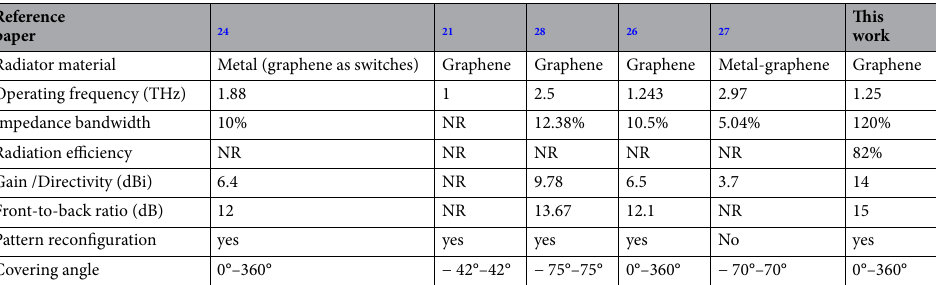
Table 5. Performance comparison of proposed antenna with previously published graphene-based Yagi-Uda THz antenna. NR Not